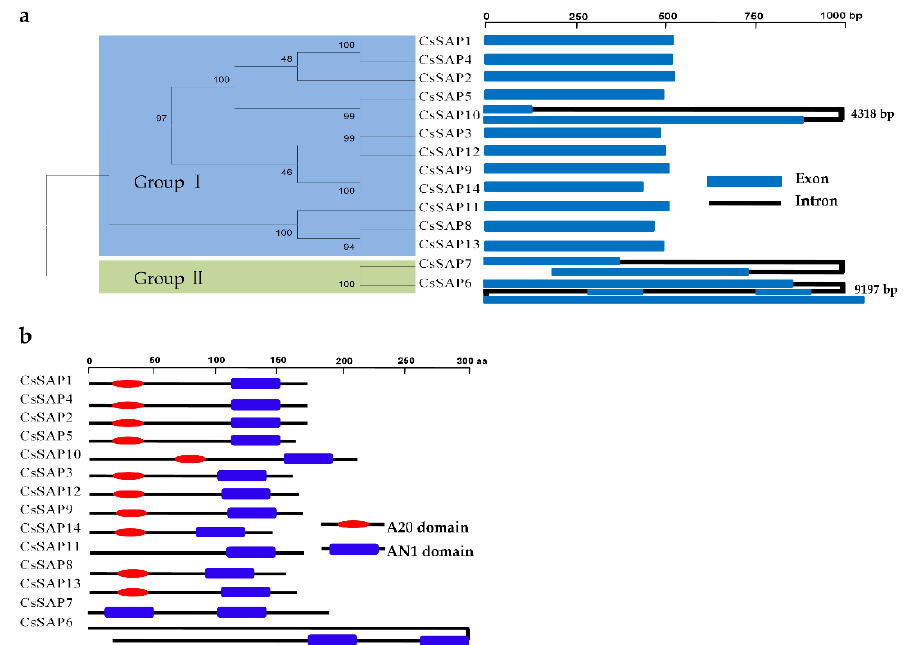
Figure 3. Sequence analysis of CsSAPs . ( a ) Phylogenetic relationships and Gene structure analysis; ( b ) analysis of the conserved domains for CsSAPs in tea plant. The phylogenetic tree of full-length amino acid sequences was constructed using MEGA software.